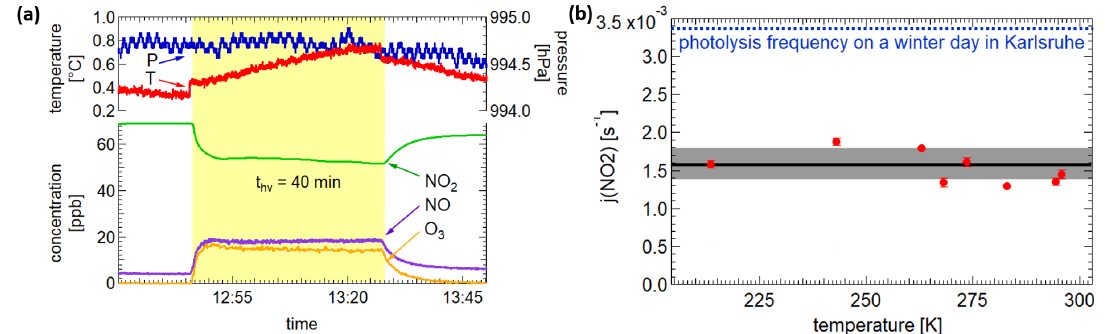
Figure 4. (a) Pressure, temperatures and concentrations during an actinometric experiment with NO 2 . (b) The resulting photolysis frequen- cies at the different